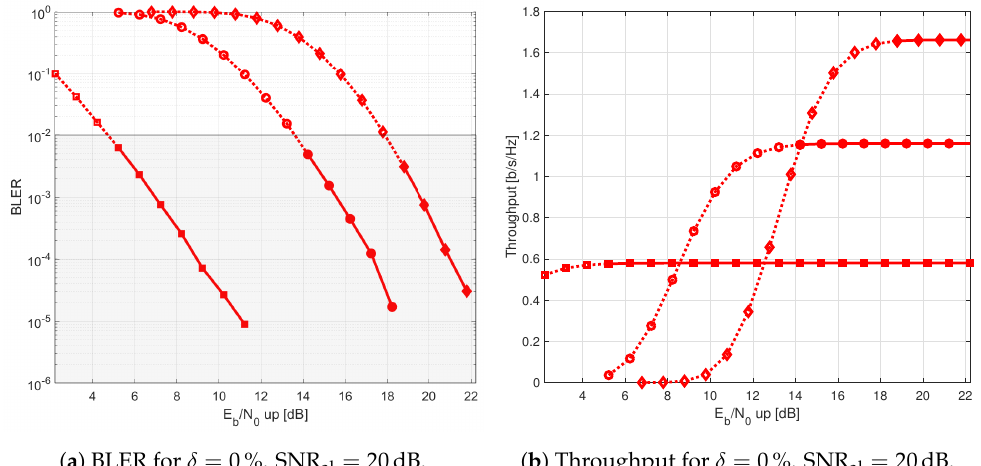
Figure 9. End-to-end BLER (left) and throughput (right) versus E b / N 0 in the feeder link for a NB-IoT frame (SNR al = 20dB). NB-IoT code rates: 0.33333 (square), 0.66667 (circle) and 0.95556 (diamond), when the wind speed is v = 21m/s. Solid (dashed-) lines with (un)filled markers: BLER ≤ 10 − 2 requirement (not) fulfilled. Diameter of telescope aperture: W 0 =